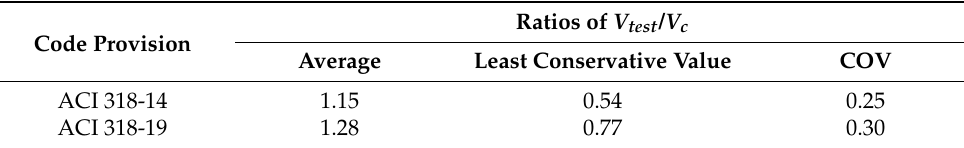
Table 6. Summary of statistical values of shear strength